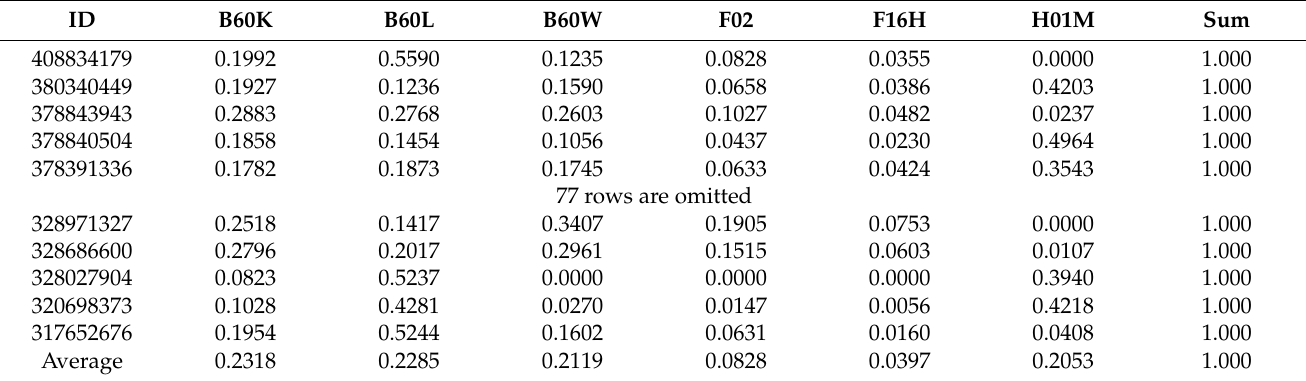
Table 5. Partial results for the probability of a patent ID being assigned to an IPC